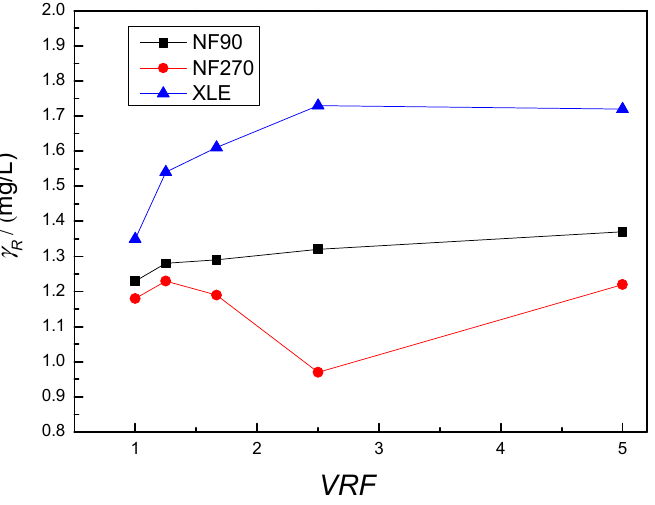
Figure 1. Dependence of mebendazole concentration in retentate on VRF value.